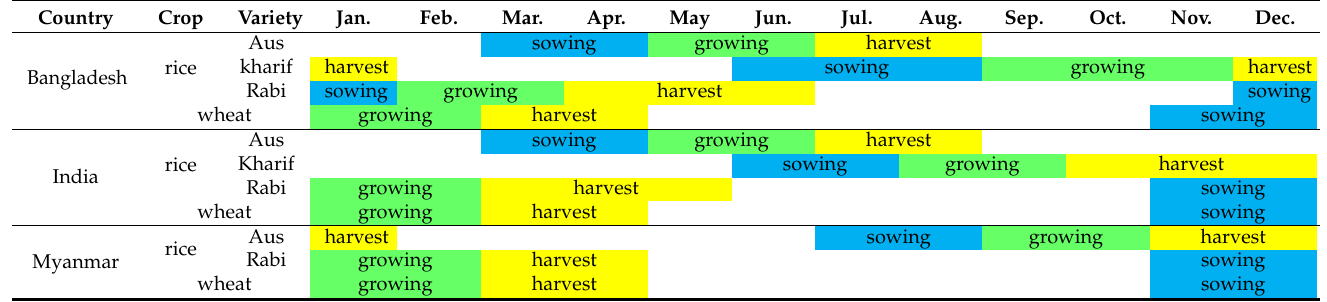
Table 1. The crop calendar for the study region of Bangladesh, India and Myanmar. The blue color is for crop sowing, green for crop growing and yellow for crop harvest.